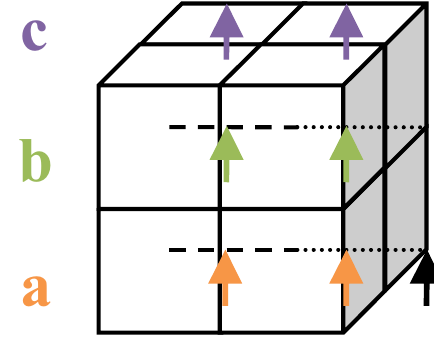
Fig. 13 Illustration of the Joint-X joints when y = b + 1